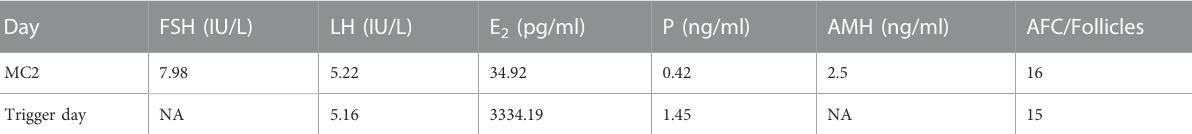
TABLE 1 Sex hormone level and ovarian reserve of the